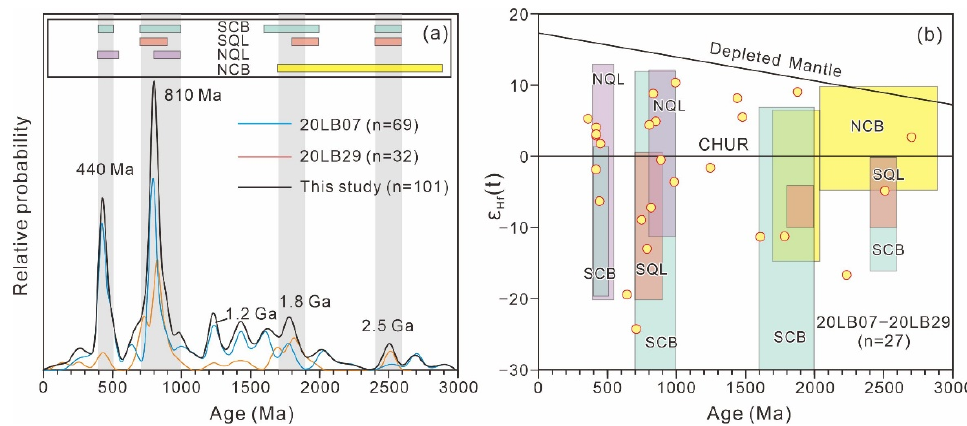
Figure 9. ( a ) Detrital zircon U–Pb age spectra of the Middle Devonian Liba Group and magmatic zircon distributions from neighboring orogenic belts. ( b ) Detrital zircon ε Hf (t) values versus U–Pb age diagram of the Liba Group. Data of North China Block, South China Block, North Qinling Belt and South Qinling Belt are from [27,52–55]. NCB = North China Block, NQB = North Qinling Belt, SQB = South Qinling Belt, SCB = South China Block.